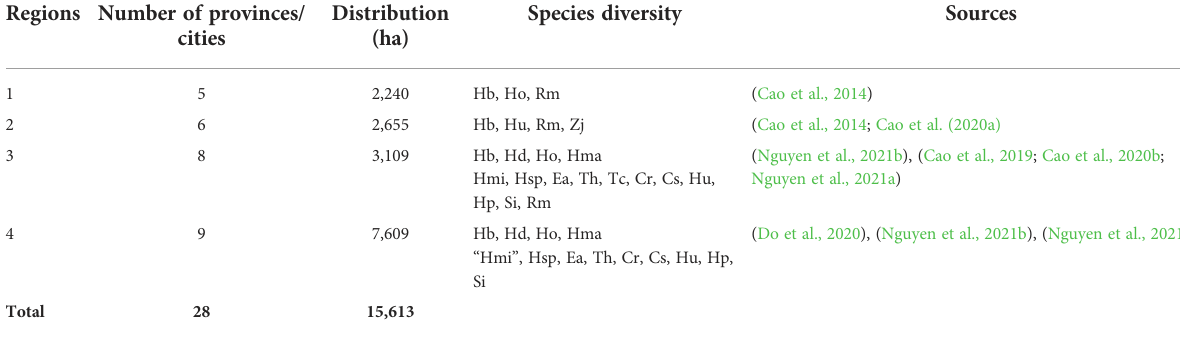
Hb, Halophila beccarii ; Hd, H. decipiens ; Ho, H. ovalis ; Hma, H. major; Hmi , putative H. minor ; Hsp, Halophila major SL type ; Ea, Enhalus acoroides ; Th, Thalassia hemprichii ; Tc, Thalassodendronciliatum ;Cr, Cymodocearotundata ;Cs, C.serrulata ; Hu,Haloduleuninervis ;Hp,H.pinifolia;Si, Syringodiumisoetifolium ;Rm, Ruppiamaritima .Zj, Zosterajaponica .See Figure 1 for the location of the